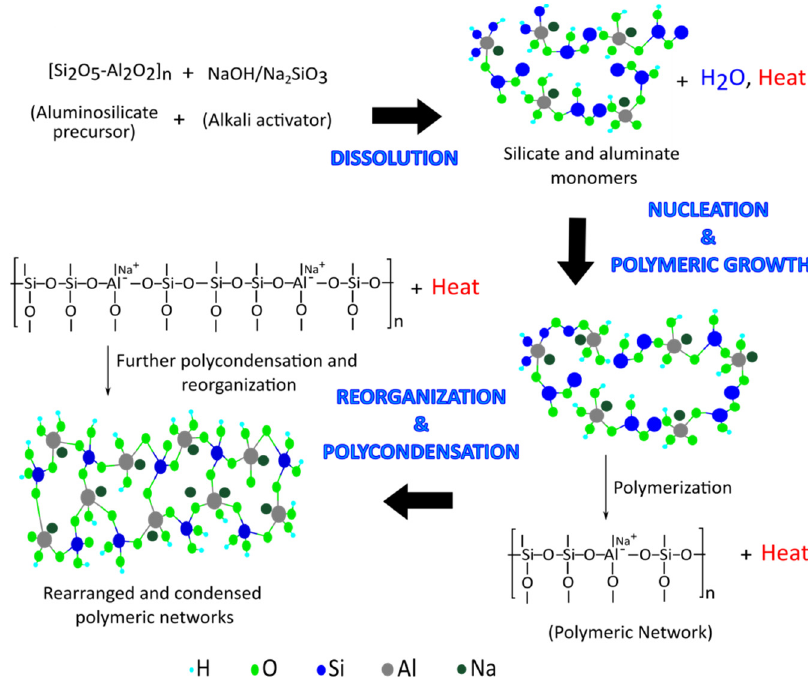
Figure 2. Conceptual process of geopolymerization.